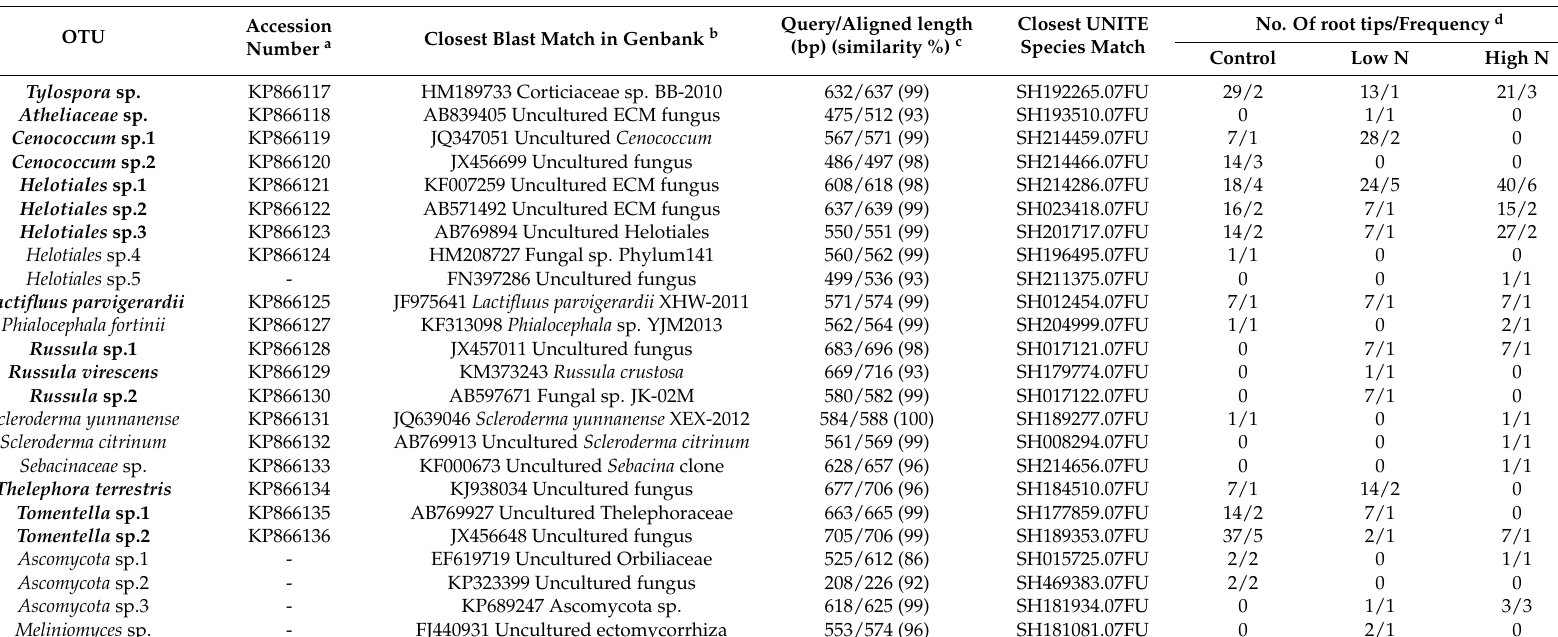
Table 2. Identification of ectomycorrhizal fungal operational taxonomic unit (OTU)s associated with Pinus elliottii growing at the study site in Hunan botanic garden, China. Species for group level enzyme analysis were tagged in bold